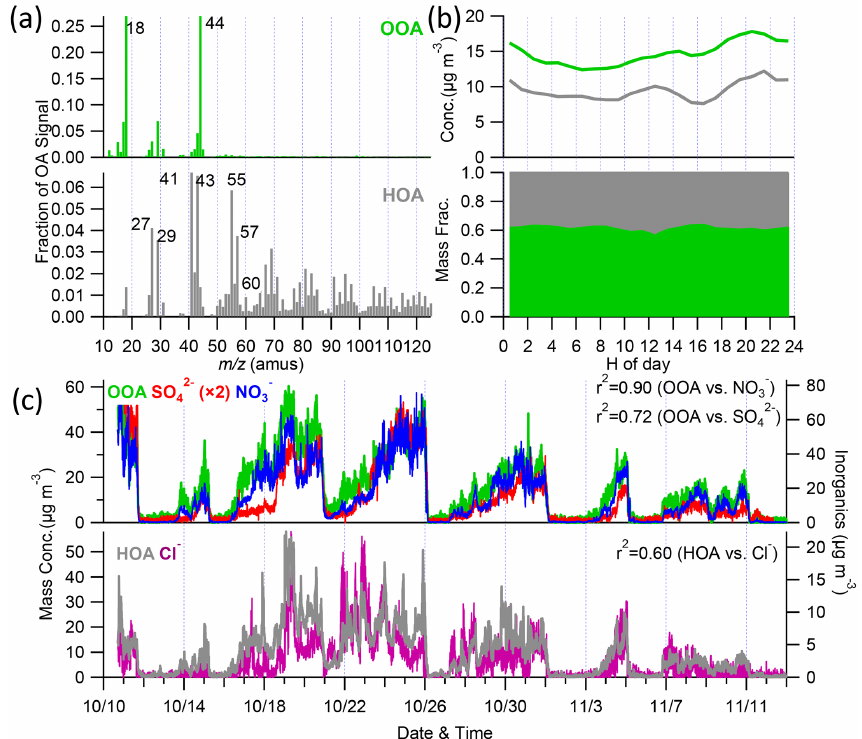
Figure 4. (a) Mass spectra of HOA and OOA, (b) diurnal variations of the mass concentration and mass fraction of HOA and OOA, (c) time series of HOA, OOA, and inorganic species (SO 2 − in the